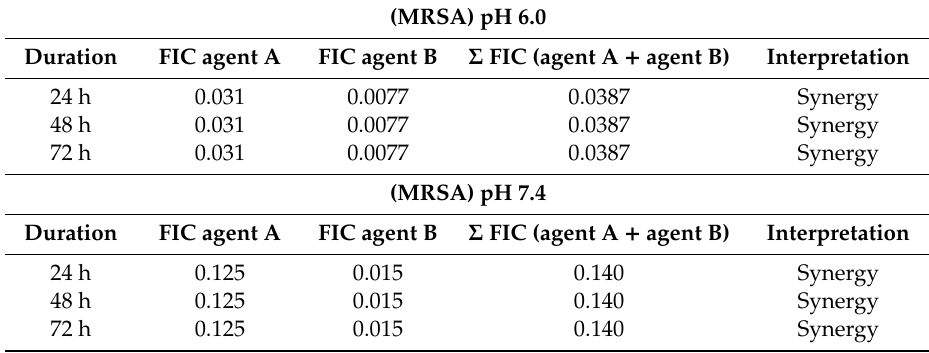
Table 5. Σ Fractional inhibitory concentration ( Σ FIC) of bare VCM and VCM-loaded quatsomes against MRSA at pH 6.0 and